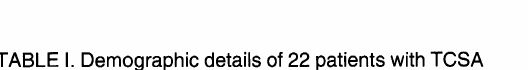
TABLE I. Demographic details of 22 patients with TCSA Patient Duration Patient group